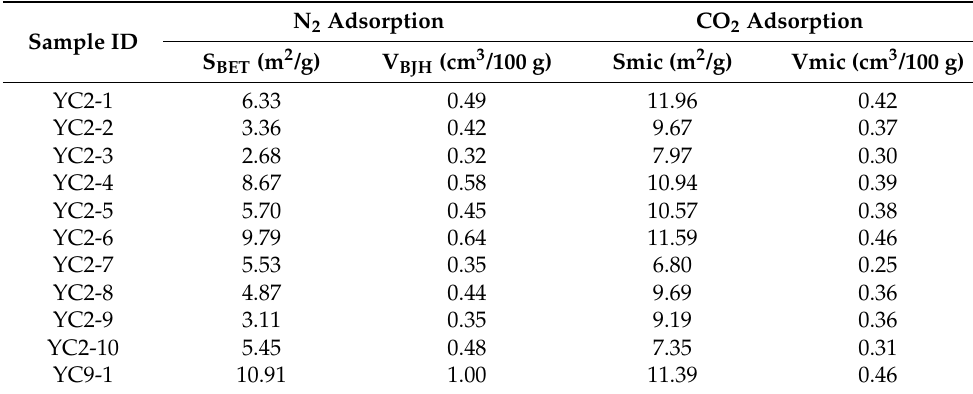
Table 3. Pore structure parameters of shale samples.